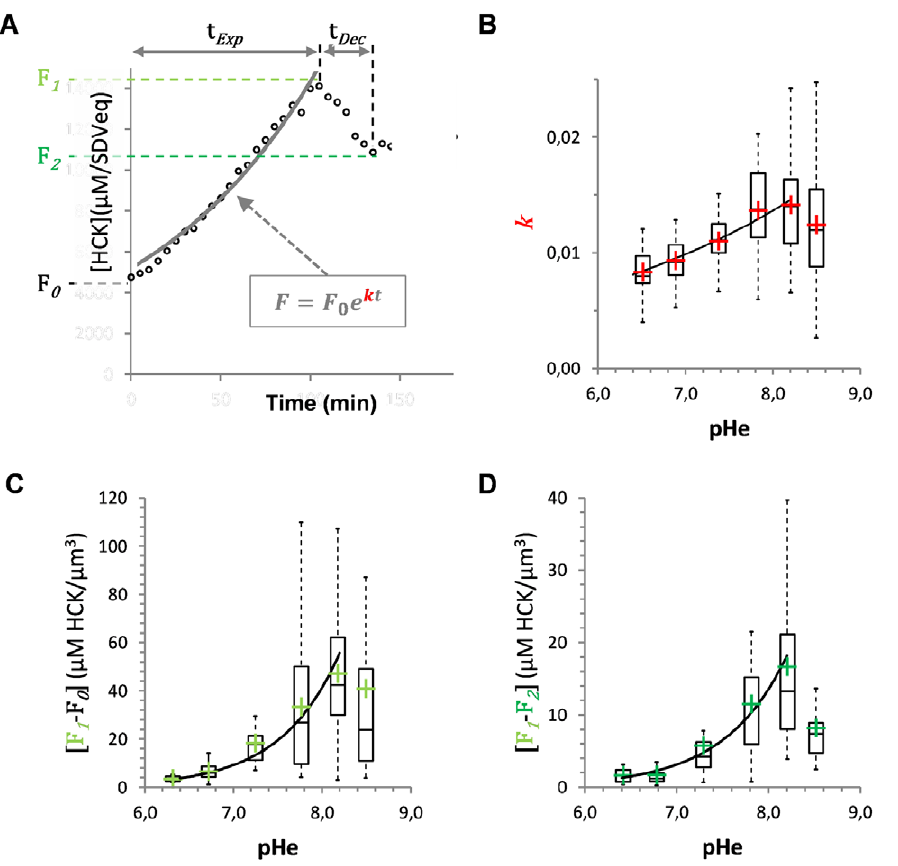
Figure 4. Influence of pHe on the kinetics of valve formation. ( A ) The initial phase of valve formation is composed of two phases: an exponential evolution of the HCK-123 signal ( t Exp ) that ends at a maximum named F 1 , followed by a decay phase that ends at the minimum ( t Dec ), named F 2 . During the first phase we fitted the data to an exponential and determined the slope ( k ) and the coordinates on the y-axis (F 0 ). ( B ) Influence of extracellular pH on k . In the 6.4–8.2 pH range, data were fitted to an exponential (y=1.1e-3.e 0.32 6 ; r 2 =0.98). ( C ) Variation of HCK-123 concentrations as a function of external pH during the exponential (F 1 -F 0 ) phase. In the 6.4–8.2 pH range, data were fitted to an exponential (y=1e- 4.e 1.50 6 ; r 2 =0.98). ( D ) Variation of HCK-123 concentrations during the decay (F 1 -F 2 ) phase. In the 6.4–8.2 pH range, data were fitted to an exponential (y=5e-5.e 1.47 6 ; r 2 =0.95). Data are from 7 to 92 single-cell measurements.